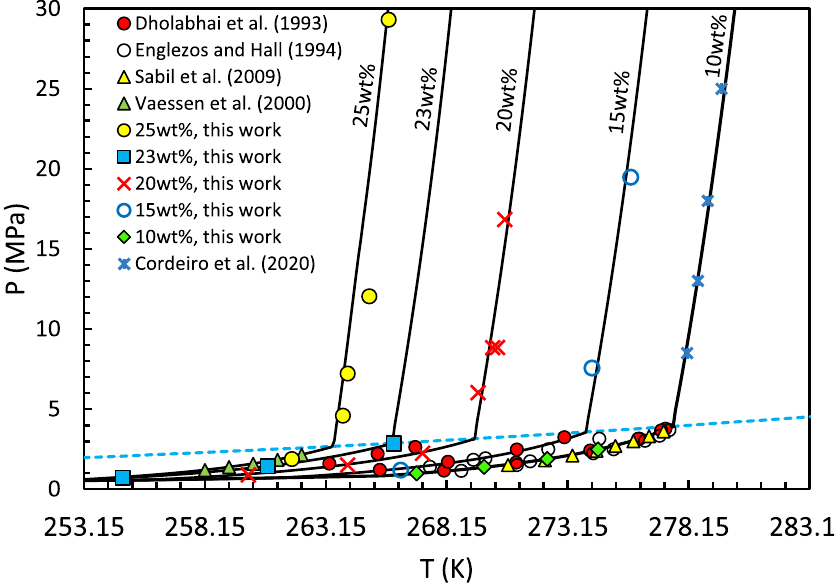
Fig. 5. Predicted and experimental hydrate stability of the CO 2 system in presence of aqueous sodium chloride solution in VLH and LLH regions; black lines: hydrate stability zone predicted using the CPA-EoS model using an aqueous mole fraction of 0.8; dotted blue lines: vapour – liquid locus of CO 2 (no water) using the CPA-EoS